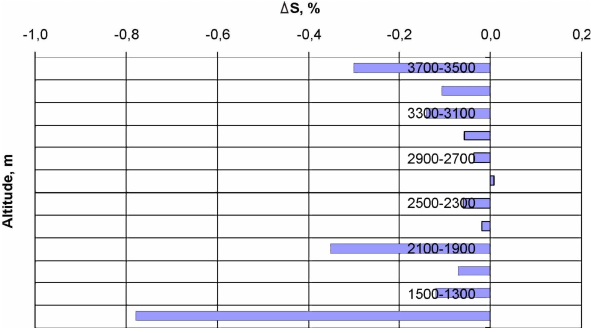
Fig. 5. The empirical curve of the ice distribution versus altitude as the difference between 30-year surveys for four glaciers (two Alpine and two